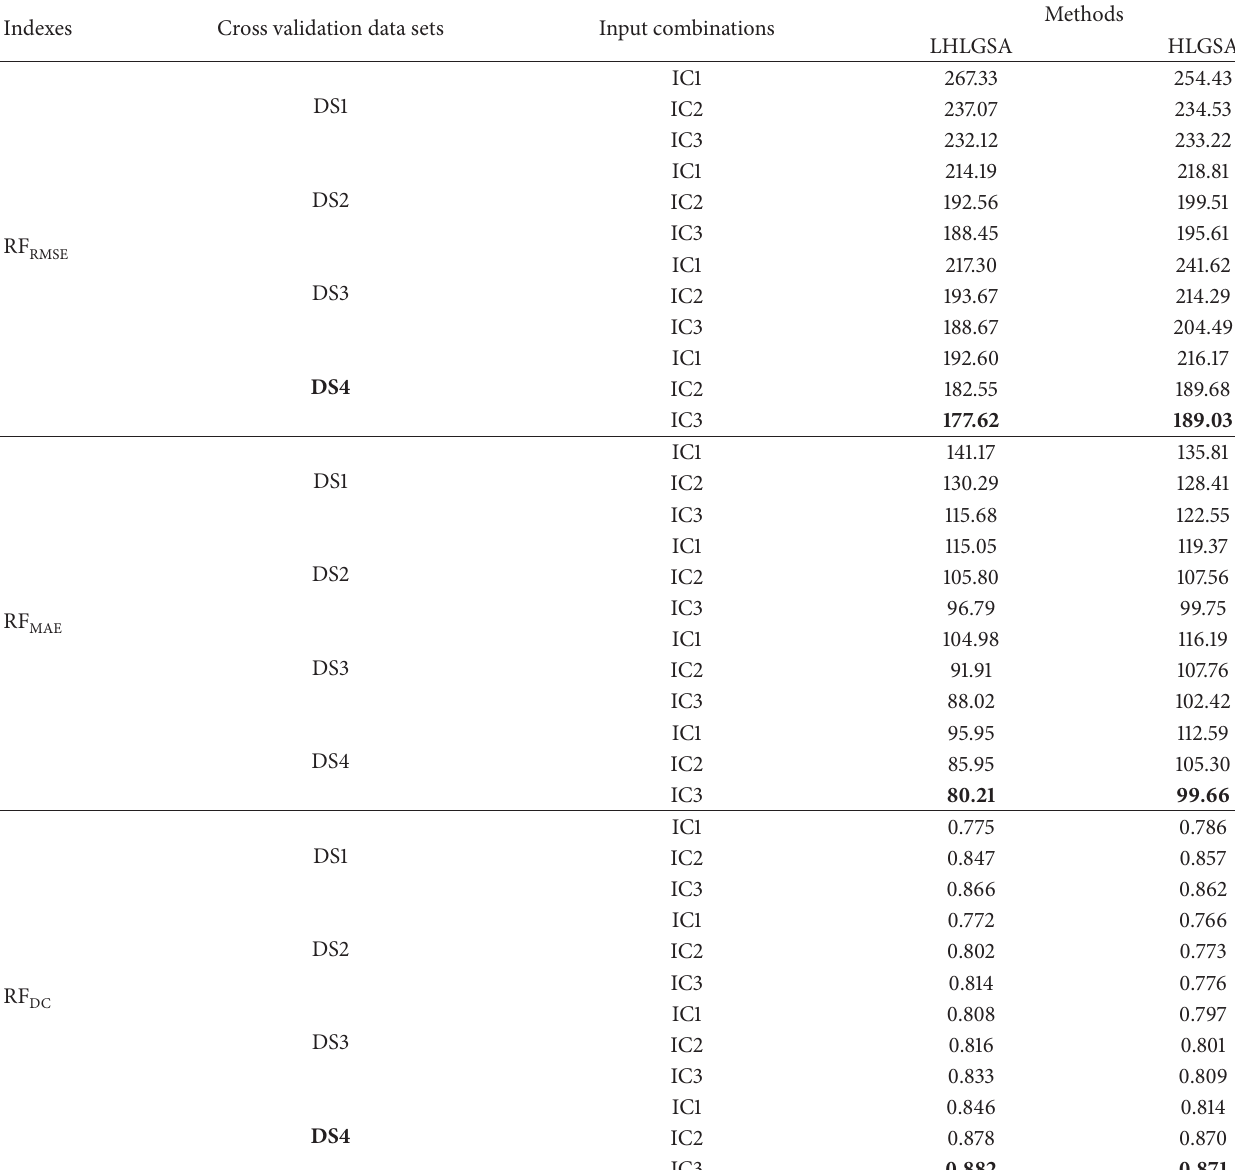
Table 7: Comparison of the LHLGSA and HLGSA methods in estimating river flow of the Shyok catchment by using the data of Astore